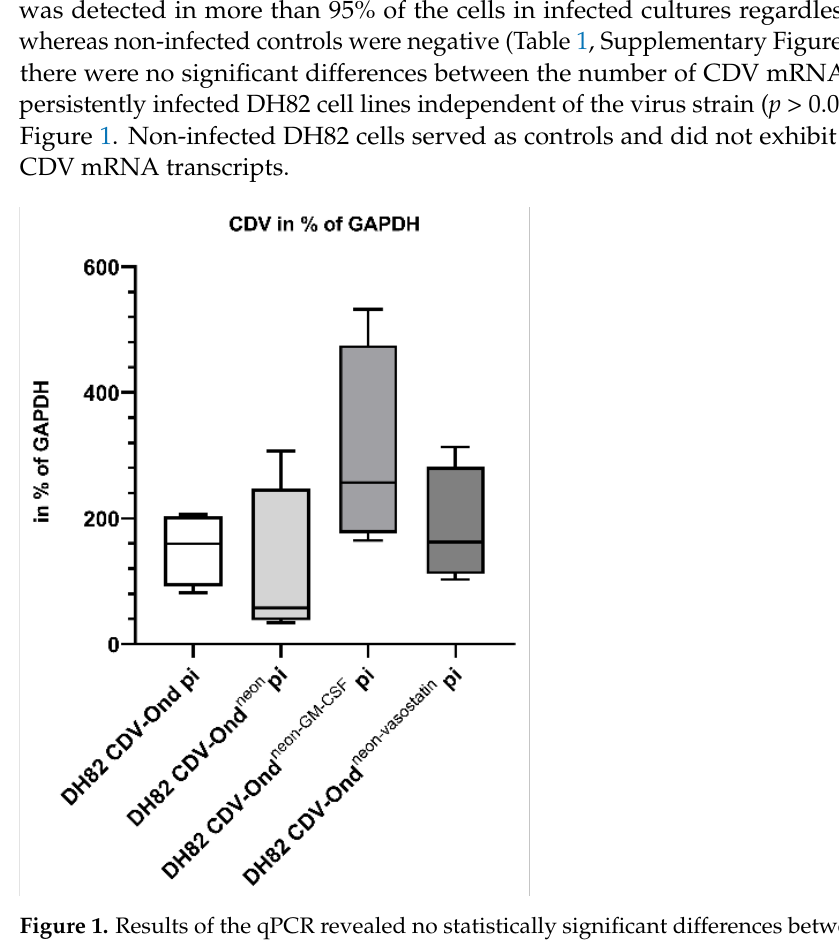
Figure 1. Results of the qPCR revealed no statistically significant differences between the different persistently infected cell lines (Mann–Whitney-U test; p > 0.05). Box plots represent minimum, first quartile, median, third quartile and maximum.